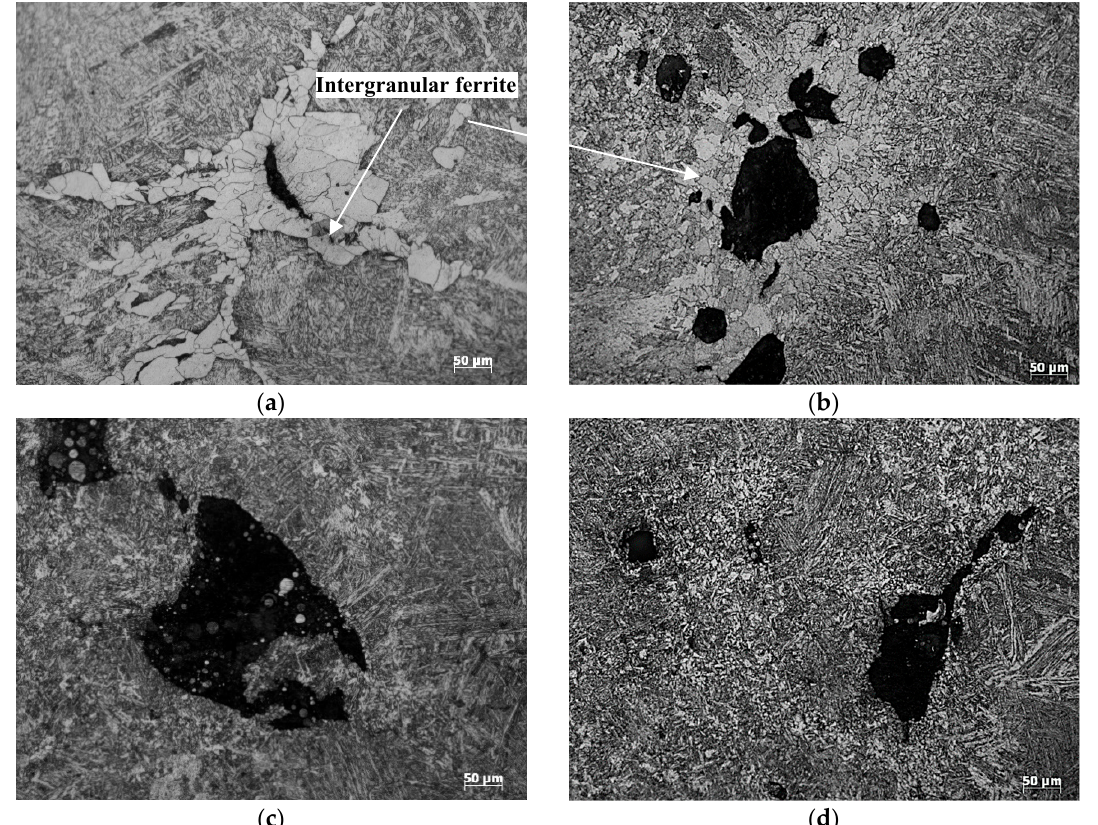
Figure 2. Microstructure near the fractures of hot tensile specimens: ( a ) S1; ( b ) S2; ( c ) S3; ( d ) S4.